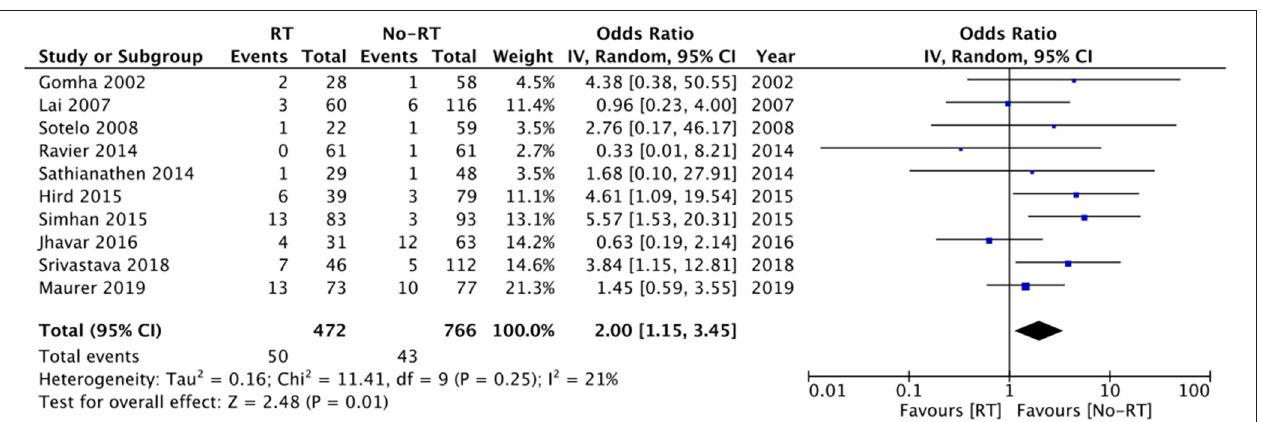
FIGURE 5 | Meta-analysis of erosion between RT and no-RT groups.